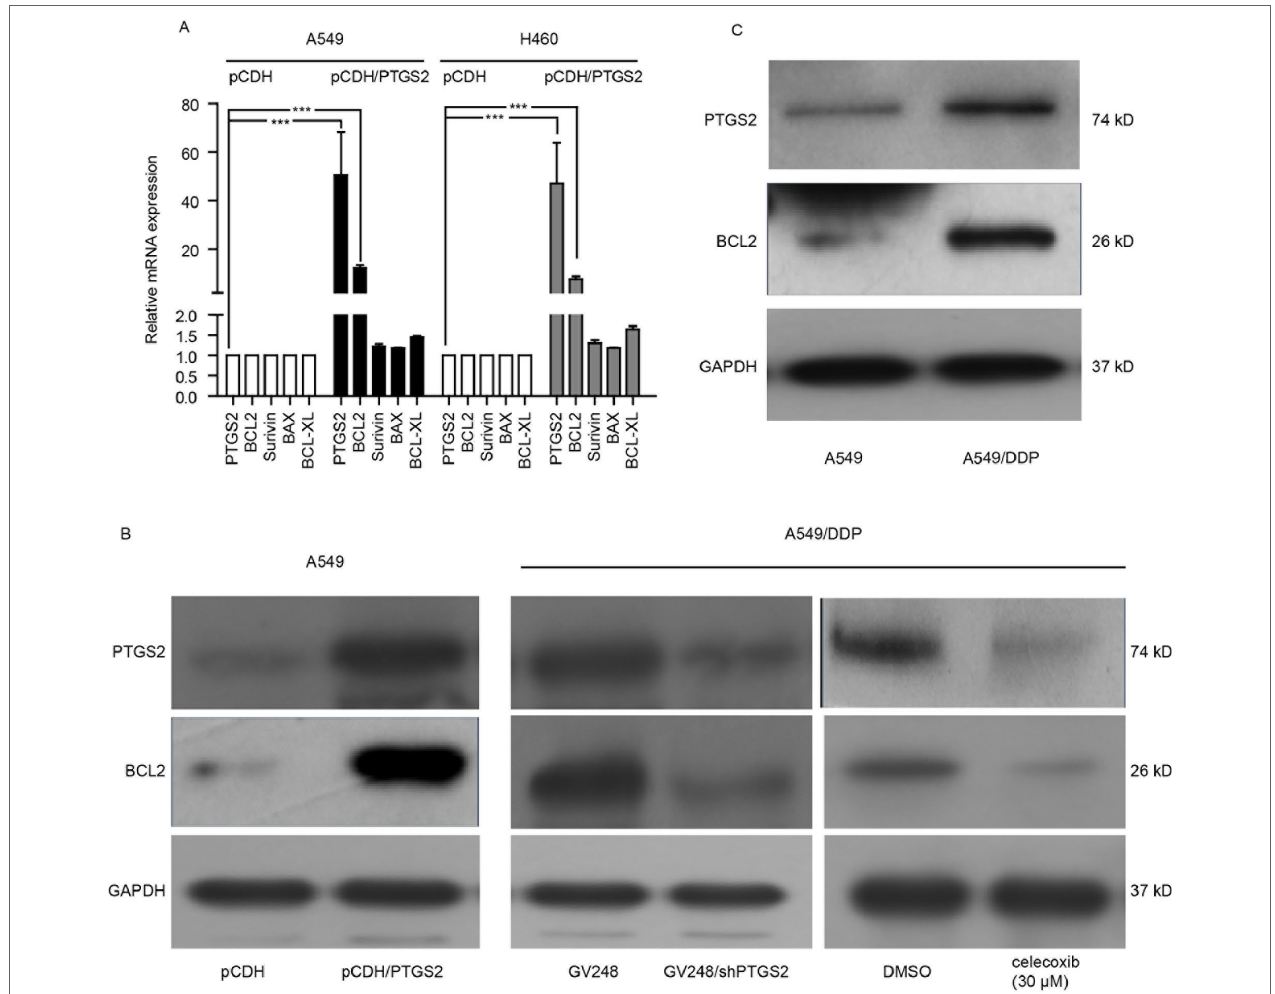
FIGURE 3 | PTGS2 up-regulated BCL2 expression. (A) Analysis of PTGS2 on the expressions of apoptosis-related genes ( BCL2 , Survivin , BAX , and BCL-XL ) in NSCLC cells by q-PCR. Cells (5 × 10 6 ) were lysed by Trizol to obtain total RNA, which was subjected to produce cDNA for q-PCR analysis of the apoptosis-related genes. (B) A549-pCDH and A549-pCDH/PTGS2 cells (2.5 × 10 6 ) or A549 / DDP-GV248 and A549 / DDP-GV248/shPTGS2 cells (3 × 10 6 ) were lysed to obtain protein samples for immunoblot analysis with PTGS2 and BCL2 antibodies. (C) Comparison of PTGS2 and BCL2 expressions in A549 and A549/DDP cells by Western blotting. *** P <